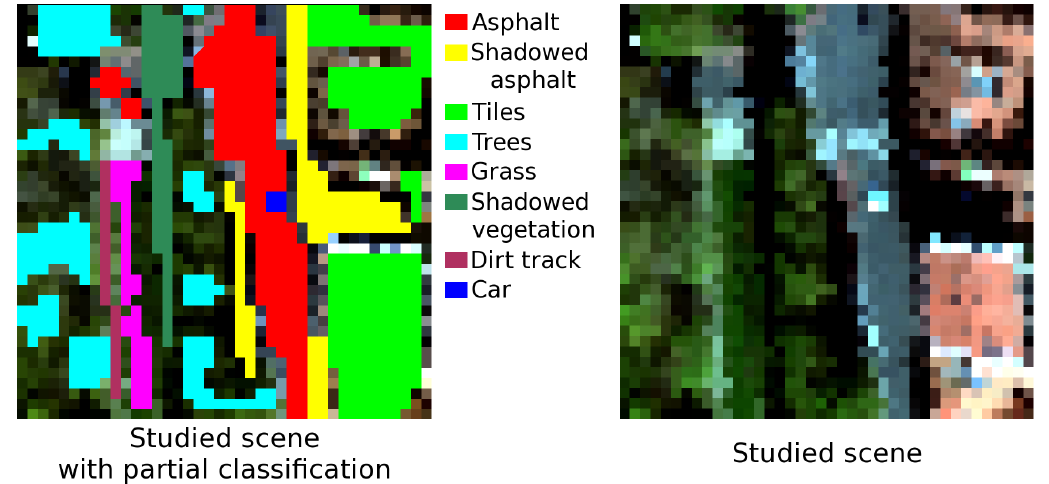
Figure 11. A zoom of the studied scene (right-hand side) in real colors (647 nm 542 nm 454 nm) and a manual partial classification of this scene (left-hand side). The manual partial classification allows a better understanding of the selected